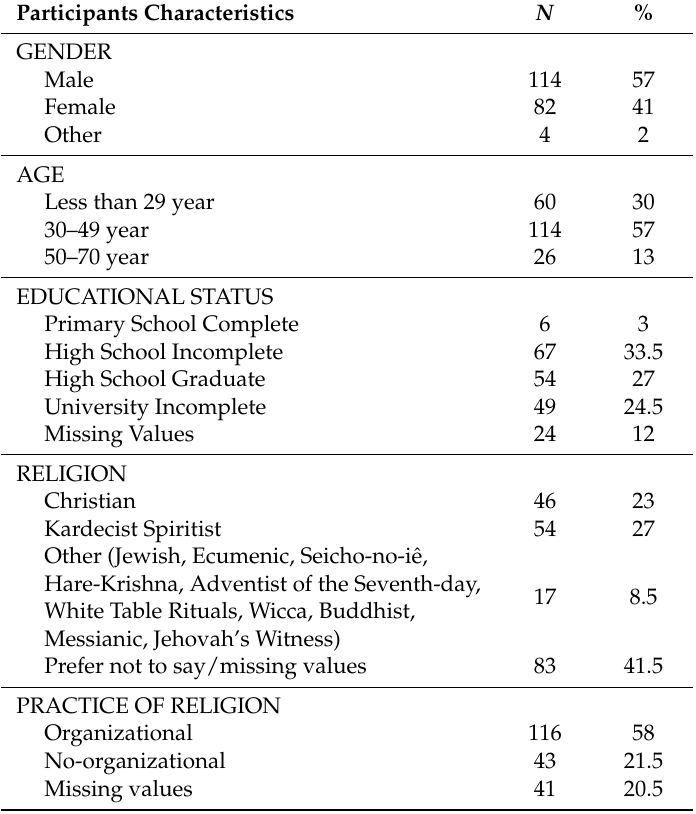
Table 1. Demographic characteristics and religion of HIV positive Brazilian participants ( N =